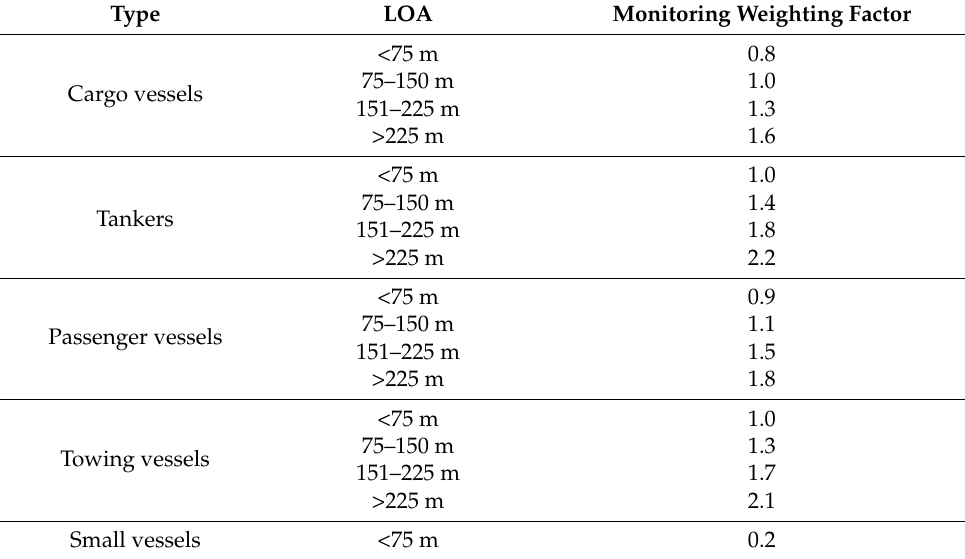
Table 2. Monitoring weighting factor based on the vessel type and length.